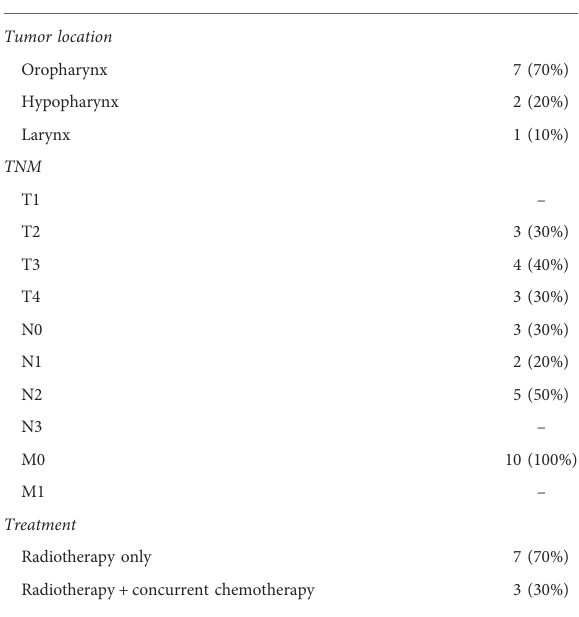
TABLE 1 Tumor and treatment characteristics of all patients included in this imaging study. Treatment and tumor